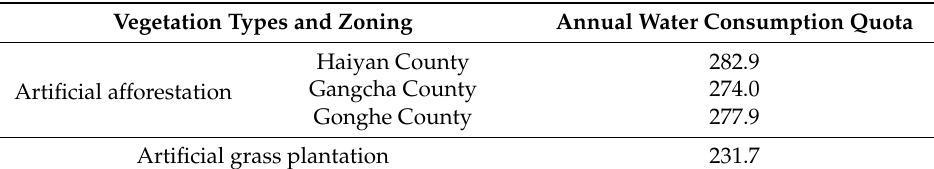
Table 4. Water consumption quota of artificial vegetation in Qinghai Lake basin (mm).